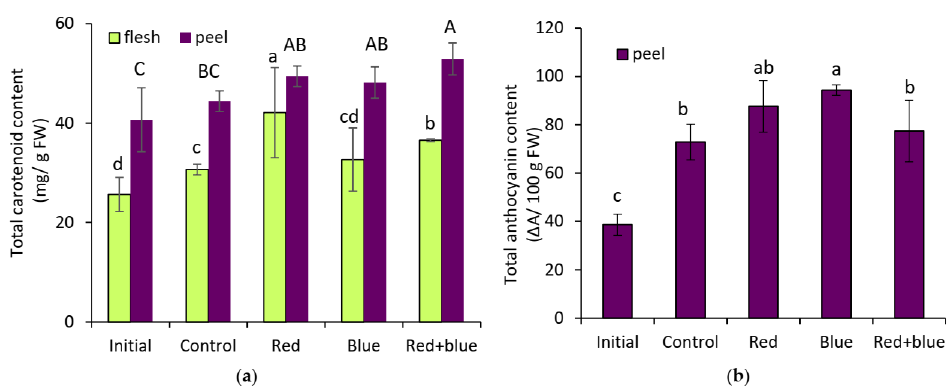
Figure 1. Effect of different LED lights on bioactive compounds: ( a ) total carotenoid content in flesh and peel of eggplants and ( b ) total anthocyanin content in peel of eggplants. Different letters a–d and A–C indicate statistically significant differences ( p < 0.05) according to Duncan’s multiple range test. Error bars show means ± SD ( n =